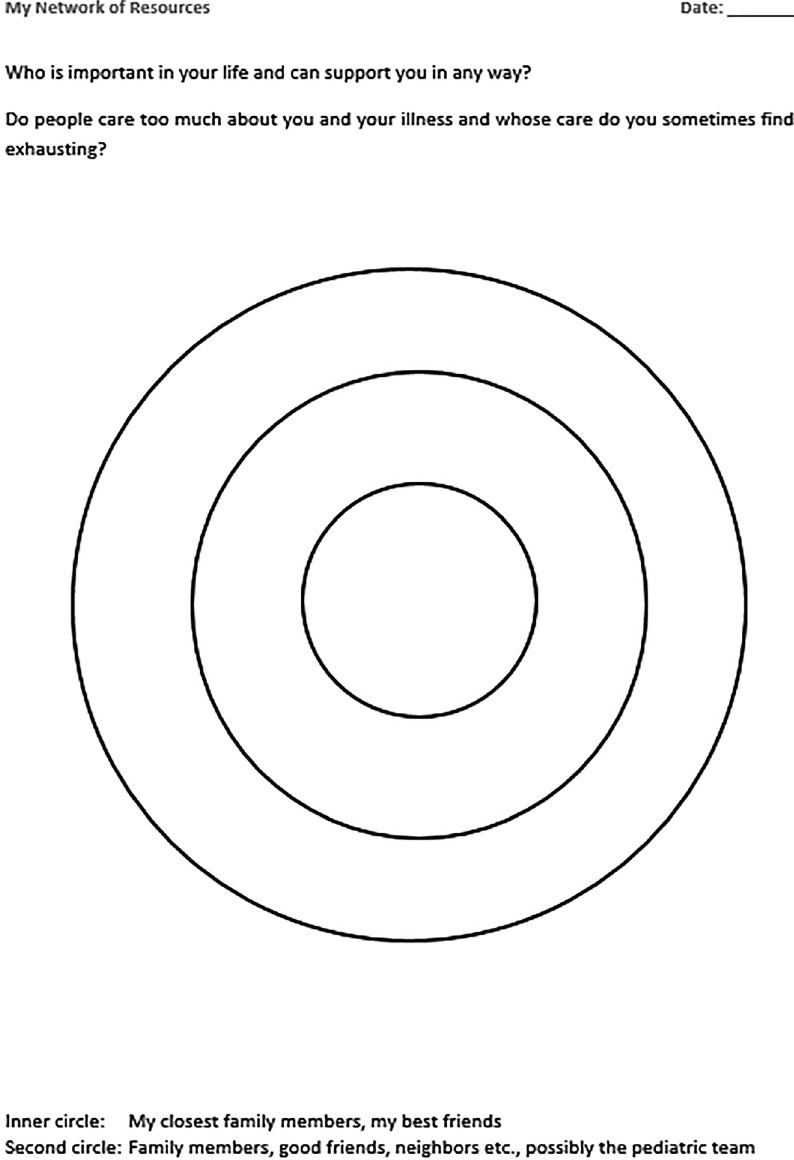
Figure1: Oneofthemodules ’“ MyNetworkof Resources ” methods: the circle of